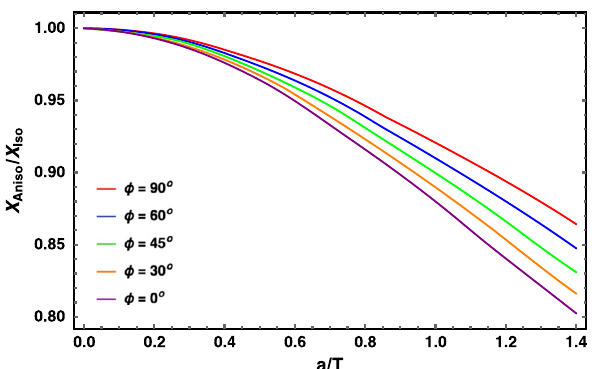
Fig. 2 The ratio of the stopping distances in the anisotropic geometry to the AdS − Sch metric for different values of a / T . Red line shows the ratio for x Aniso = x trans v erse , while the purple line stands for x Aniso = x longitudinal . Here we fix the temperature of both backgrounds and the string has the same energy and virtuality in both backgrounds